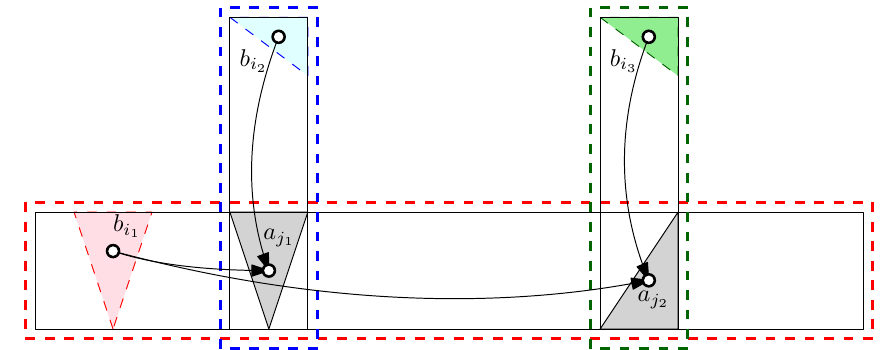
Figure 5. Illustration of the binary linear program for covering